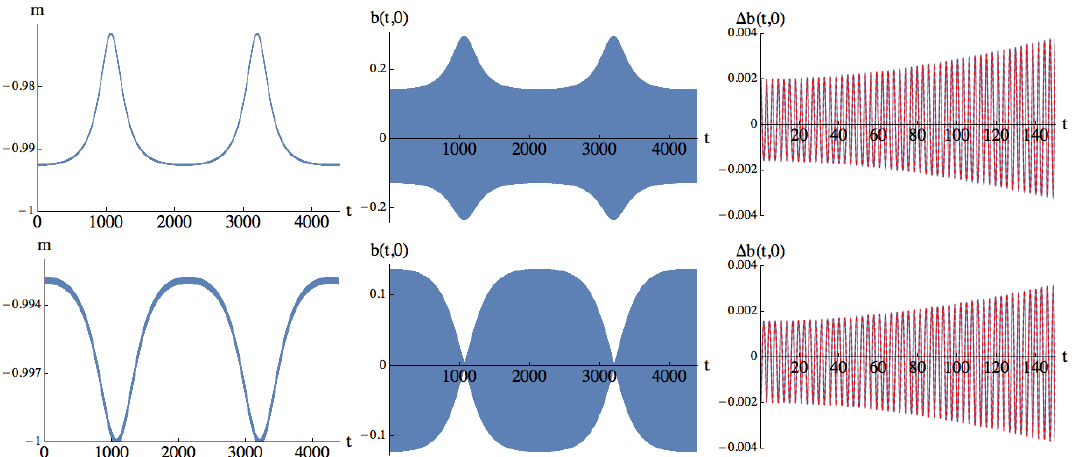
Figure 3 . Numerical simulations of the initial data (3.6) for the TPS: (cid:26) = 10 (cid:0) 4 , (cid:26) t = 0 : 14 and ! = 2 : 137. The upper plots correspond to (cid:15) = 10 (cid:0) 3 and the lower ones to (cid:15) = (cid:0) 10 (cid:0) 3 . The plots on the left show the evolution of the energy density, the middle ones the evolution of b ( t; z 0 ). On the right, we compare the di(cid:11)erence (cid:1) b ( t; z 0 ) = b ( t; z 0 ) (cid:0) b p ( t; z 0 ) (in blue) with the linearized unstable normal mode ~ b 0 ( t; z 0 ) (in dashed red), showing full